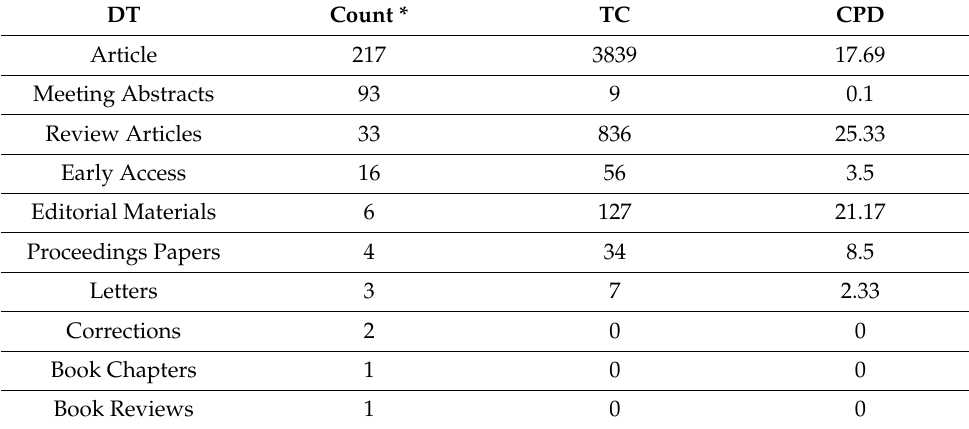
Table 1. Document types of PA field in